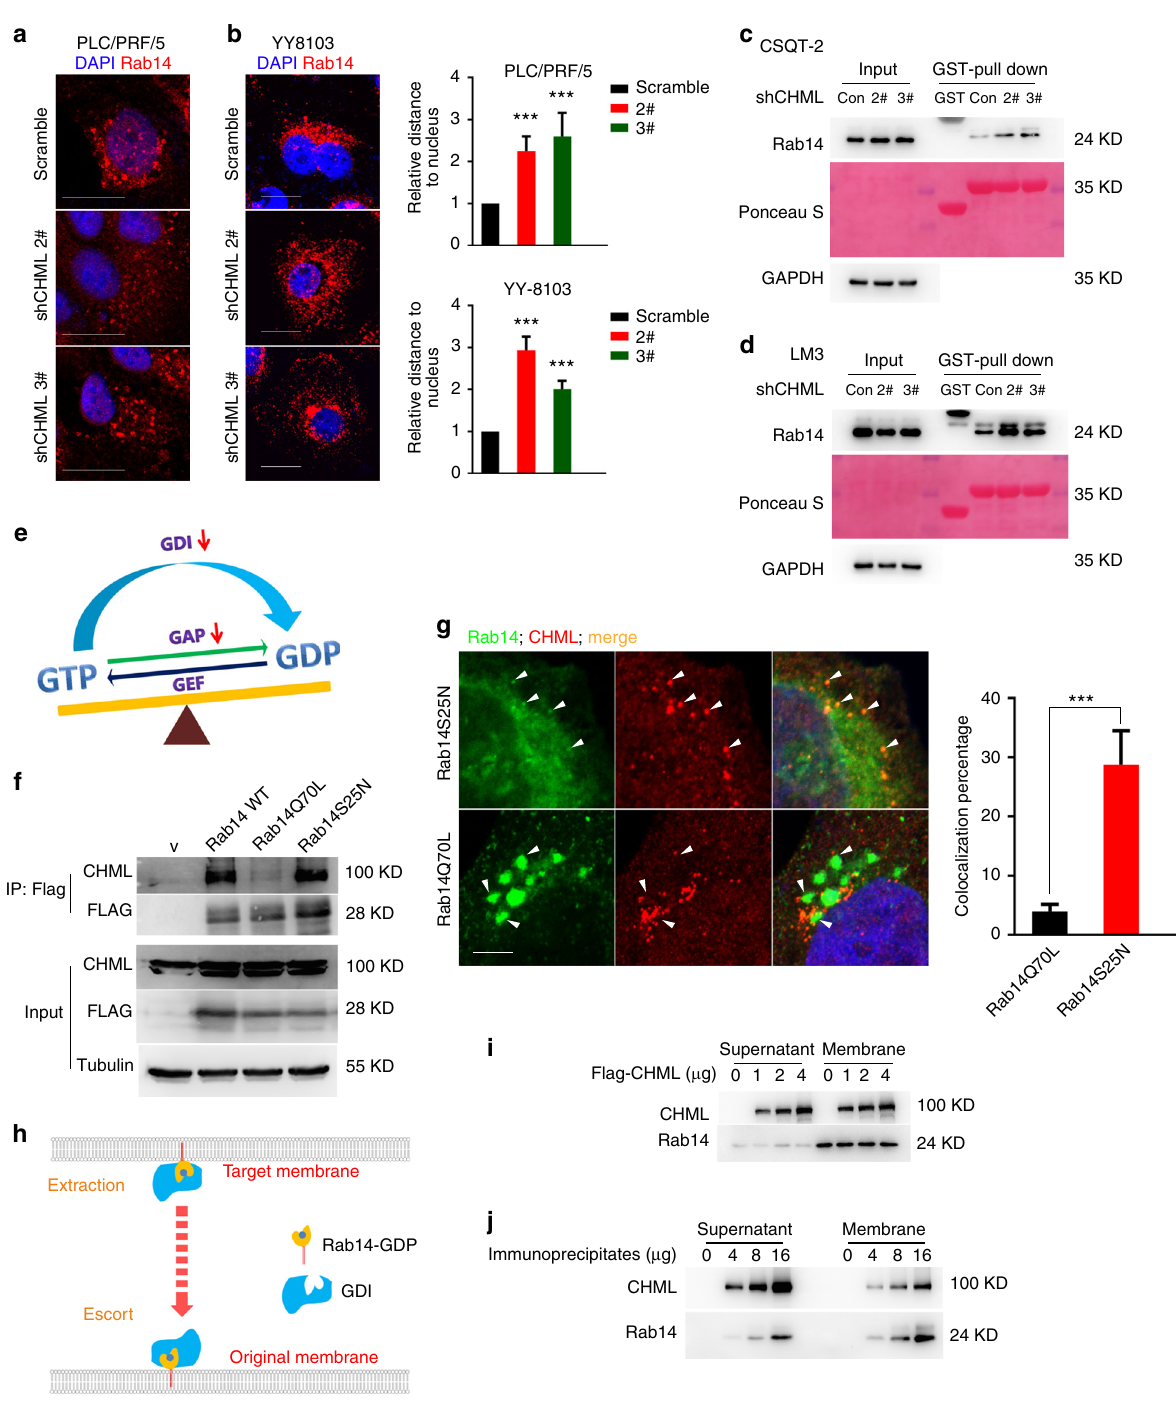
Fig. 6 CHML serves to escort Rab14 to membrane. a , b Localization of endogenous Rab14 in PLC/PRF/5 ( a ) and YY8103 ( b ) cells was stained and representative images are shown. The distances of signals to nucleus were calculated and statistically presented. *** P < 0.001, Student ’ s t -test. Scale bar, 20 μ m. c , d Rab14-GTP in shCHML CSQT-2 ( c ) and LM3 ( d ) cells was pulled down by GST- Δ RCP559-649. Ponceau S indicates GST- Δ RCP559-649. e Schematic showing factors in fl uencing Rab-GTP. f 293T cells were transfected with control vector and Rab14WT, Rab14Q70L, and Rab14S25N plasmid, respectively. After 48 h, immunoprecipitation assay was performed. g 293T cells were transfected with EGFP-Rab14S25N or EGFP-Rab14Q70L plasmid, and after 48 h endogenous CHML was stained. Images were photographed by a laser scanning microscope. Scale bar, 5 μ m. White arrowheads indicated merged signal. The percentage of merged signal was counted and presented in bar plot. *** P < 0.001, Student ’ s t -test. h Schematic showing the function of GDI. i PLC/PRF/5 Membrane fraction was incubated with Flag-CHML puri fi ed from 293T cells at 37 °C for 30 min, membrane Rab14 was detected by WB. j CHML immunoprecipitates from 293T cells were incubated with Rab14-depleted membrane, after incubation membrane fraction and supernatant were resolved by Western blot. All data are represented as mean ±